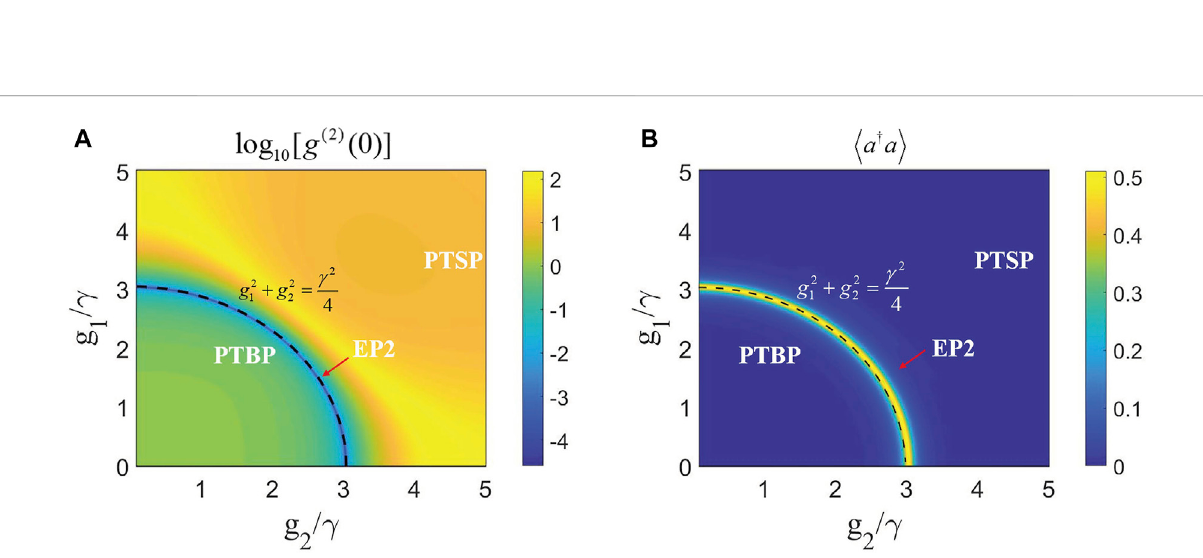
FIGURE 6 Whenthecouplingstrengthsaredifferent,i.e., g 1 ≠ g 2 , (A) thelogarithmicplotsof g ( 2 ) ( 0 ) and (B) 〈 a † a 〉 areasfunctionsofthecouplingstrengths g 1 / γ and g 2 / γ . The black dashed lines indicate the area of EP2 in the condition of g 2 1 + g 2 2 (cid:1) γ 2